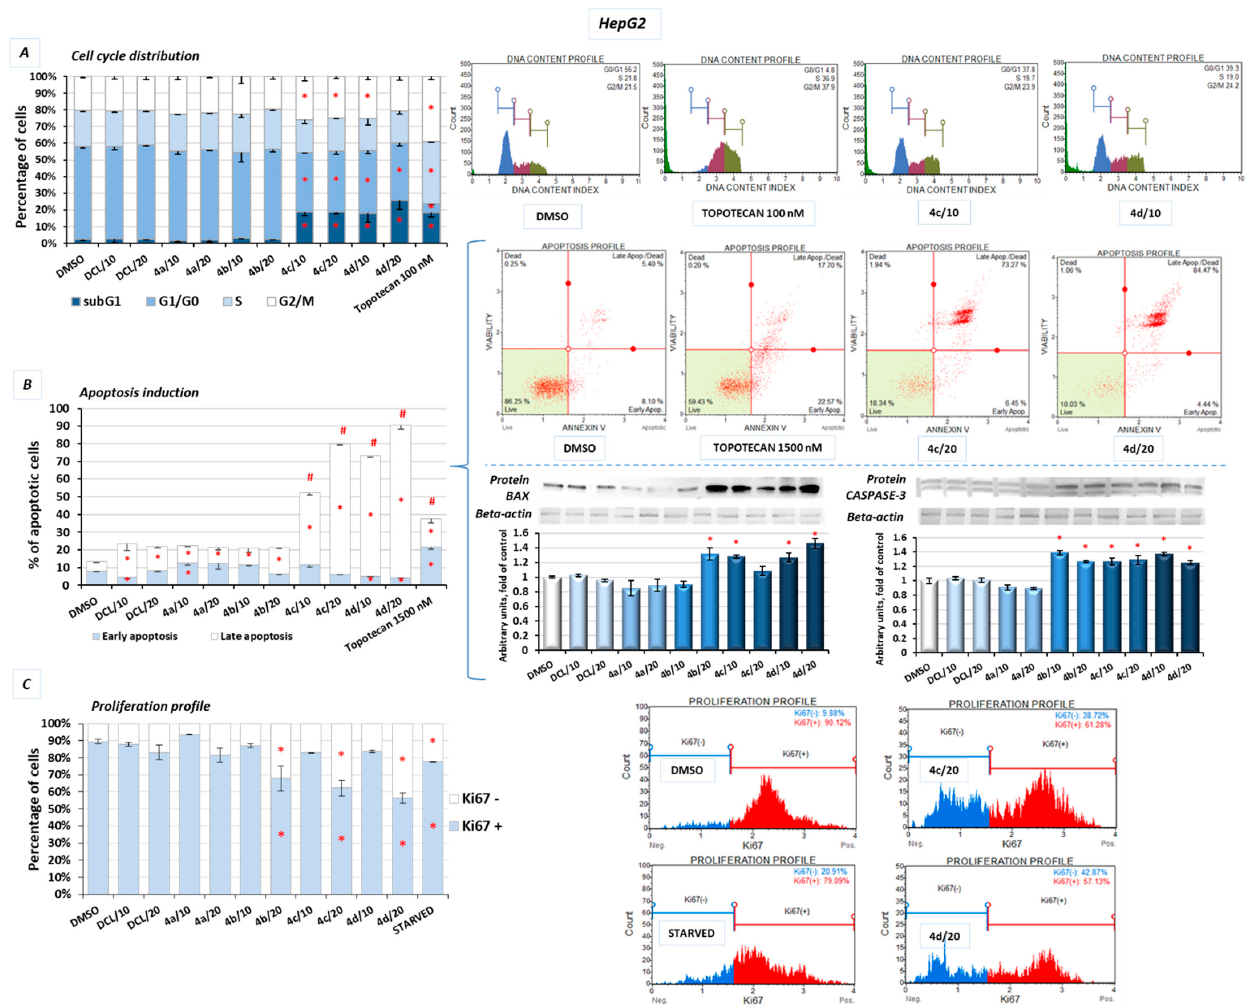
Figure 9. The effect of the DCL and DCL–OAO derivative conjugates ( 4a – 4d in 10 and 20 μ M concentrations) on the cell cycle distribution ( A ), apoptosis induction ( B ), and on the proliferation level ( C ) in HepG2 cells (after 24 h incubation). ( A ) Graphs represent the percentage of cells in the subG1 (green color before the G1 phase on plots), G1/G0, S, and G2/M phases measured by flow cytometry after propidium iodide staining. Topotecan was used as a positive control. ( B ) Graphs represent the percentage of cells in the early and late stages of the apoptosis assessed by flow cytometry measurements based on the signal from Annexin V bound to phosphatidylserine externalized in apoptotic cells. A dead cell marker, 7 ‐ AAD, was also included. Topotecan was used as a reference for proapoptotic activity. The protein levels of Bax and Caspase ‐ 3 is also presented. ( C ) Graphs representing the percentage of proliferating (Ki67(+)) and nonproliferating (Ki67( − )) cells measured by flow cytometry. Starved cells (cultured in an FBS ‐ free medium) were used as a reference for the anti ‐ proliferative conditions. Representative plots and immunoblots are presented. β‐ actin was used as a loading control for protein analysis. For all panels, the mean values ± SEM from three independent experiments is shown. Asterisks (*) denote statistically significant changes from control – DMSO treated cells, and panel B denotes statistically significant changes in the percentage of either early or late apoptotic cells, while hashes (#) denote statistically significant changes in the percentage of total apoptotic cells, p < 0.05. Statistical significance was assessed by Student’s t ‐ test.